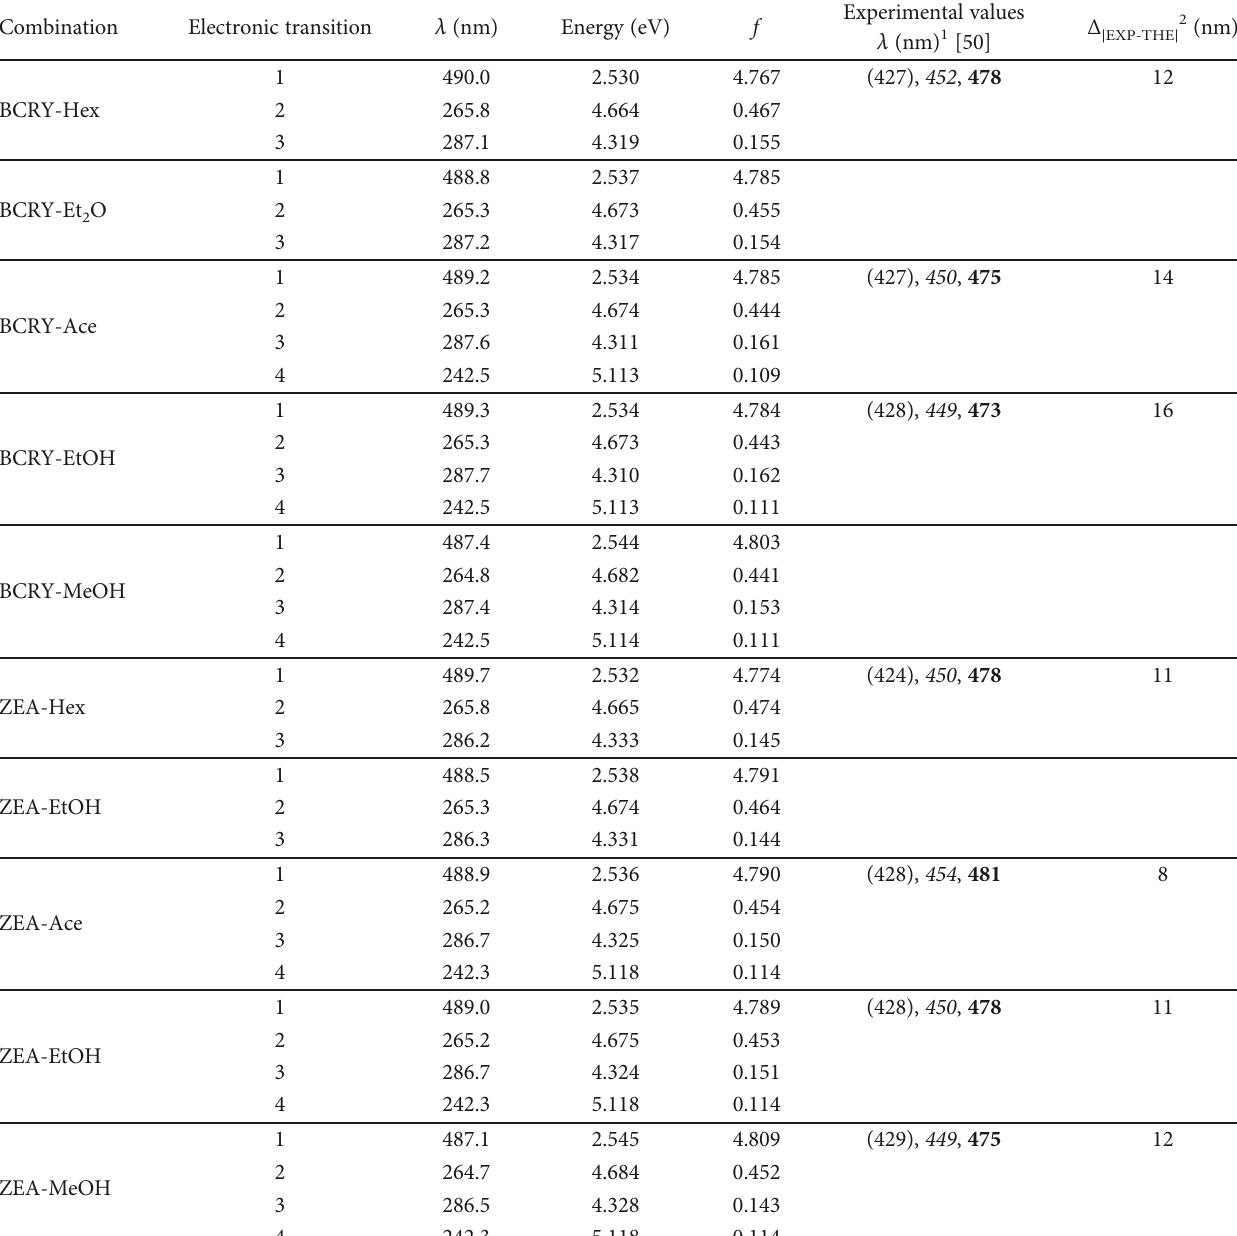
Table 5: Three or 4 main electronic transitions of the selected pigments and comparisons versus experimental values (only electronic transitions with oscillator strengths f > 0 010 are